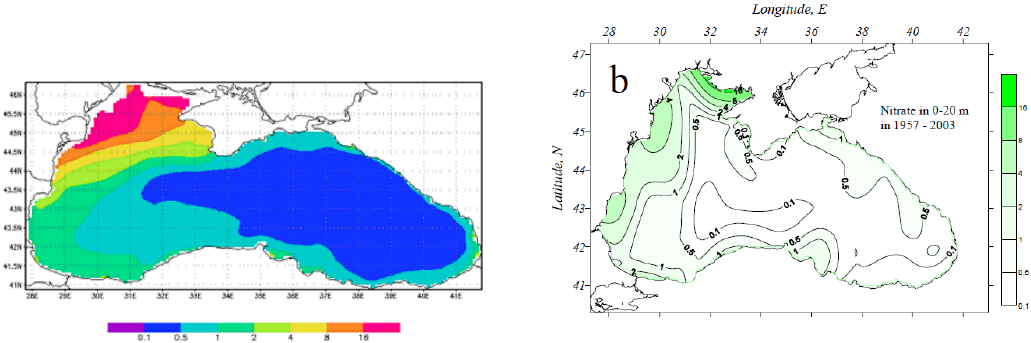
Fig. 19. An example of the surface nitrate space distribution derived from the model (left) and the map built on the basis of in-situ data (fight).